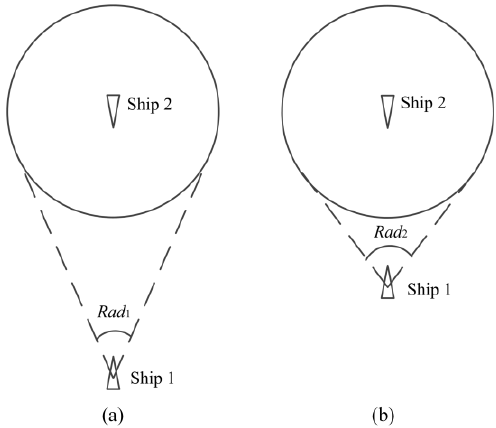
Figure 1. An exemplary danger sector of two ships in a head-on encountering ( a ) Scenario 1; ( b ) Scenario 2.